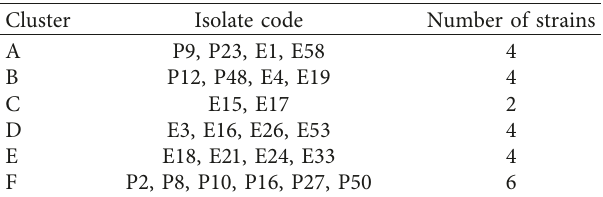
Figure 6: Dendrogram of ERIC-PCR analysis for 27 A. baumannii . (a–d) Different clusters. Table 6: Clusters of A. baumannii strains from patient and en- vironment isolates by the ERIC-PCR method. Cluster Isolate